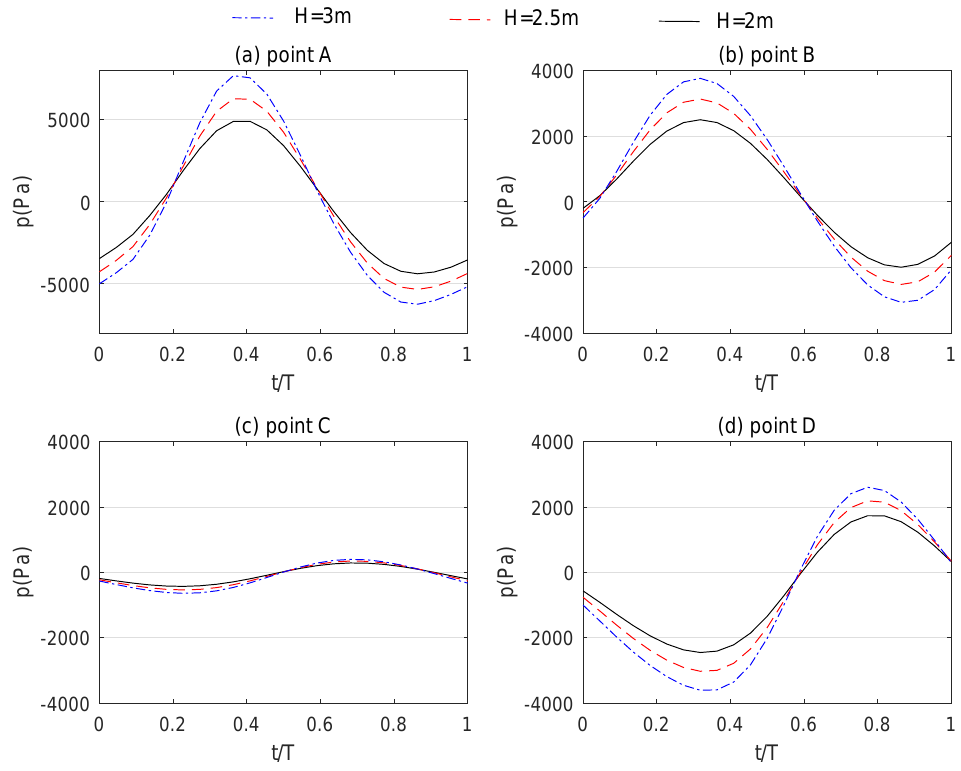
Figure 12. Distribution of the pore pressure over time in one wave cycle on four points with various wave